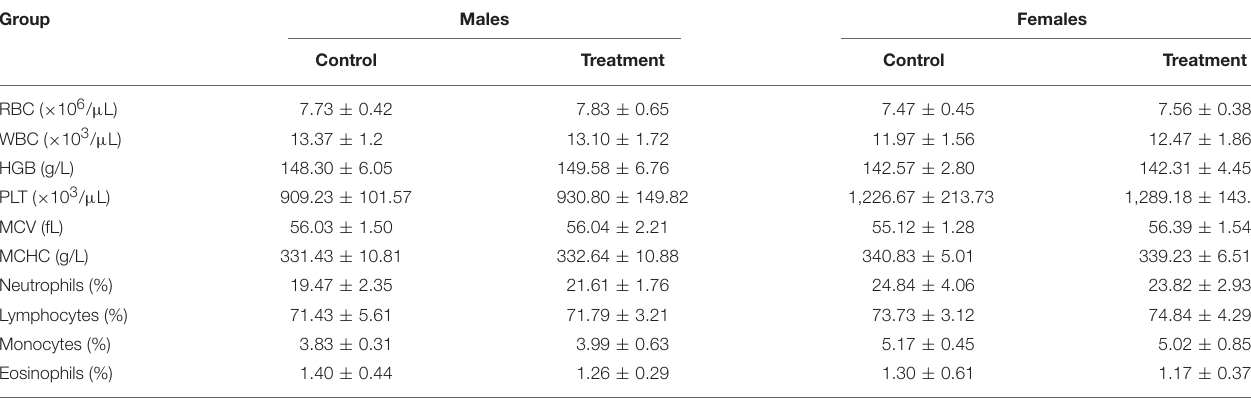
Values are presented as mean ± standard deviation (n = 6). Control, sterile normal saline; Treatment, 1 × 10 9 CFU of E. durans KLDS6.0930 /kg BW; RBC, red blood cell count; WBC, white blood cell count; HGB, hemoglobin; PLT, platelet count; MCV, mean corpuscular volume; MCHC, mean corpuscular hemoglobin